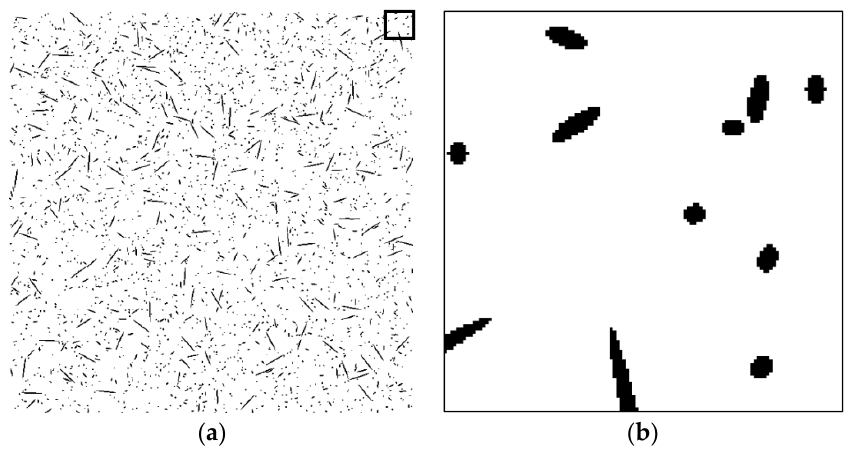
Figure 5. Artificial fiber images with a diameter of five pixels in a two ‐ dimensional random distribution in the area of 2000 pixels by 2000 pixels (I05 ‐ 2): ( a ) section image and ( b ) magnified image.